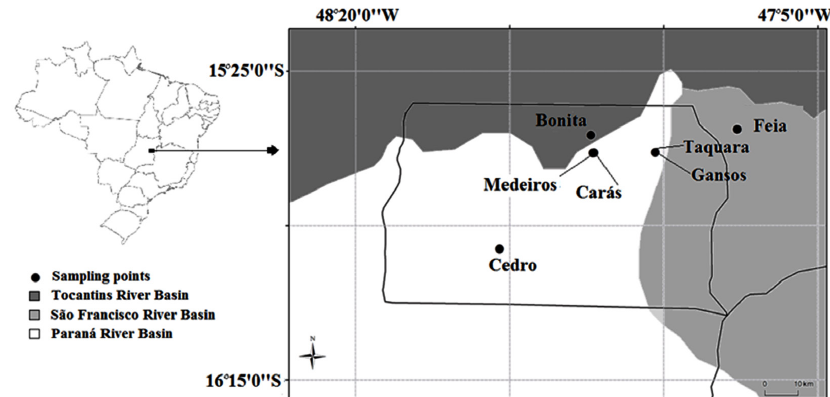
Figure 1. Geographic location of the sampling points consisting of seven shallow lakes in Federal District